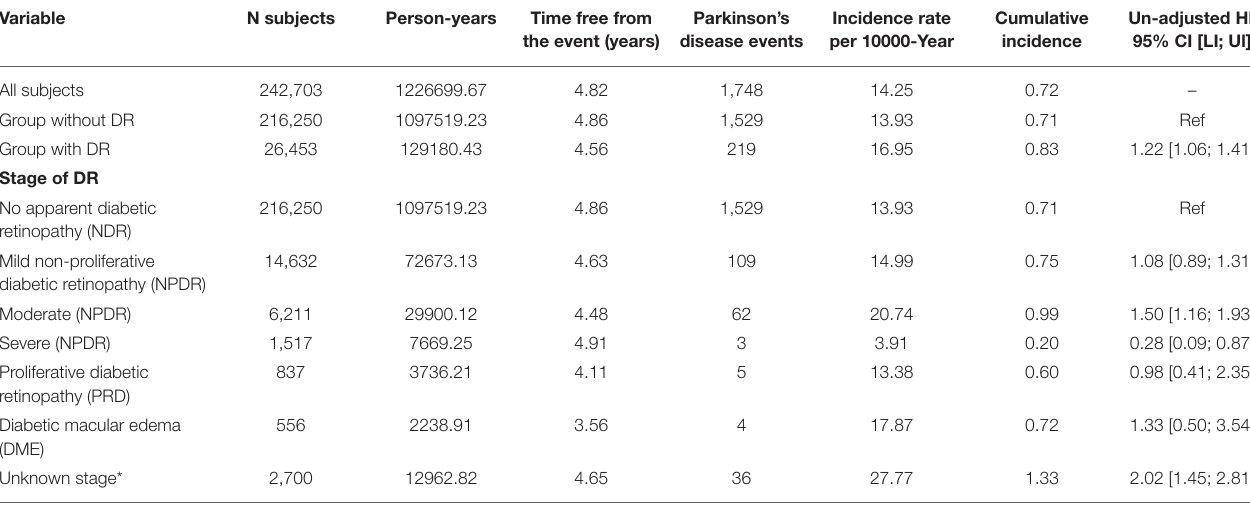
TABLE 3 | Parkinson’s disease events among the study groups, stage of diabetic retinopathy and un-adjusted hazards ratios. Variable N subjects Person-years Time free from the event